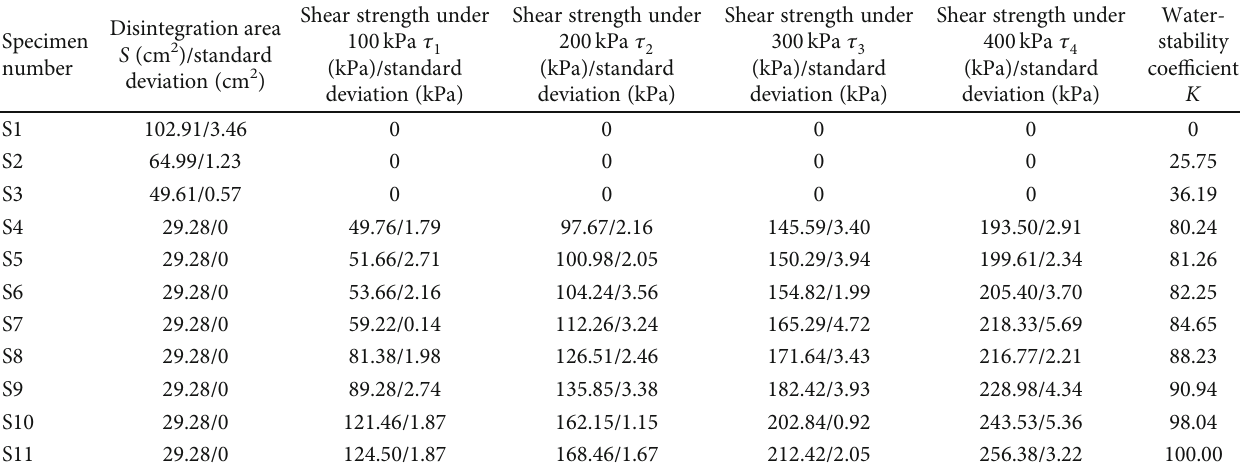
Table 3: The results of the test with di ff erent PU